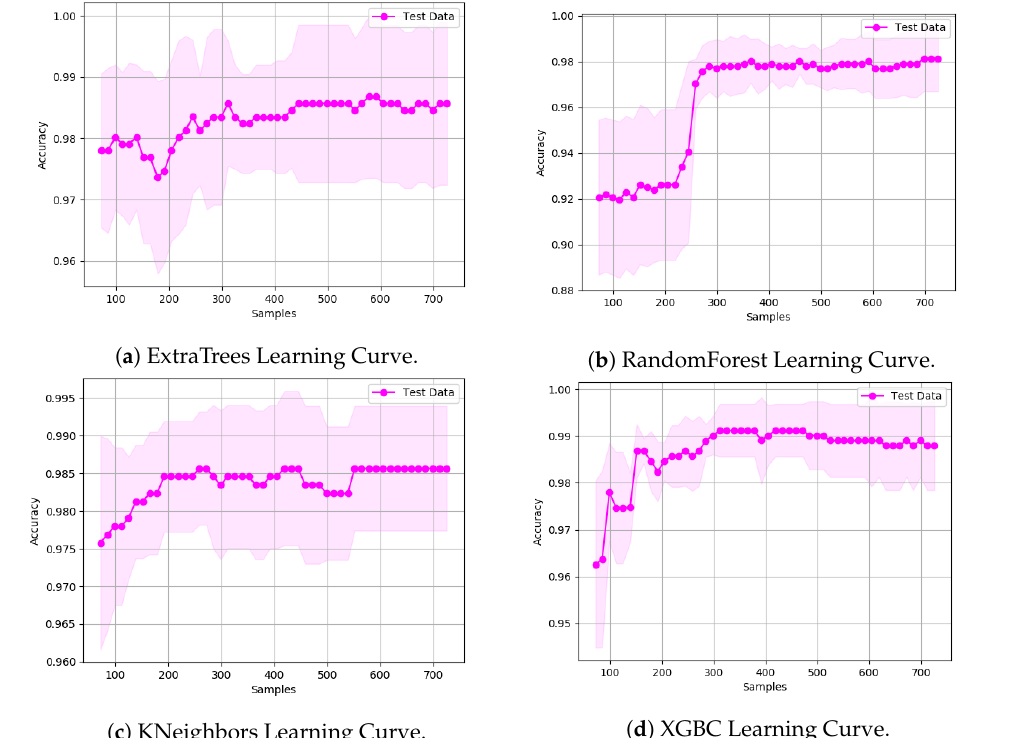
Figure 16. Example of learning curves obtained.